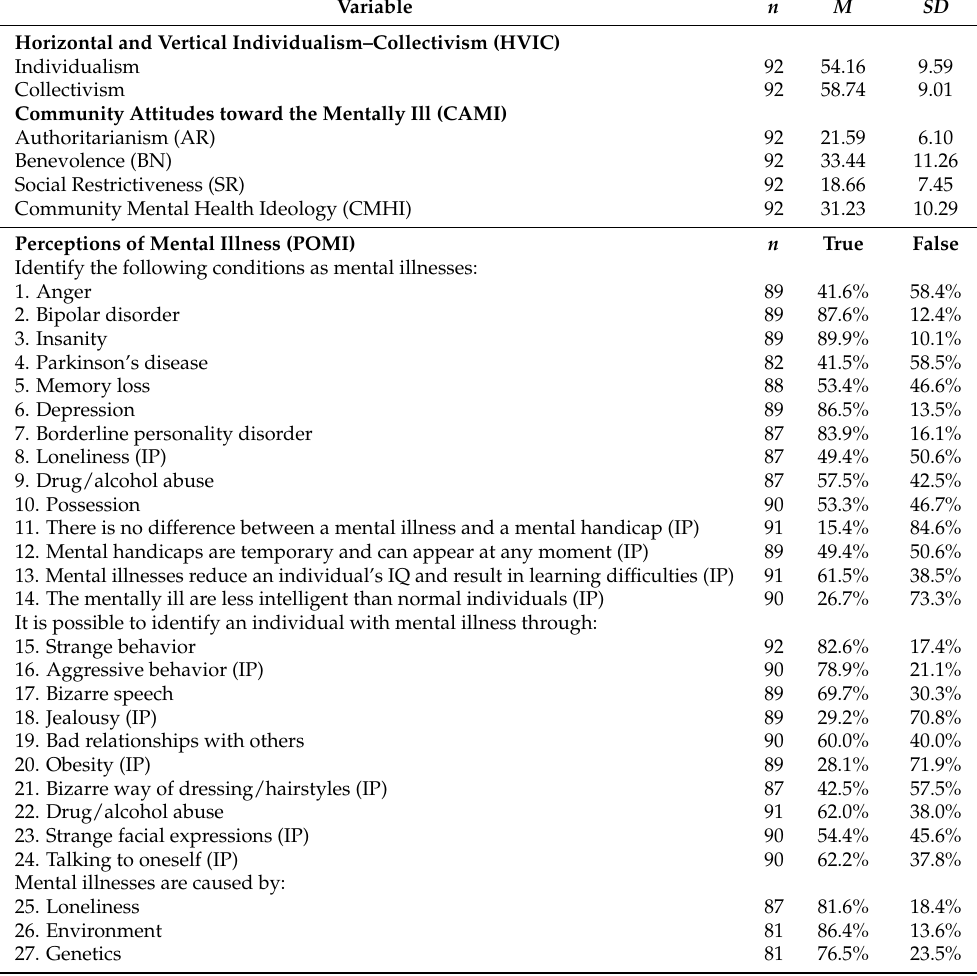
Table 2. Descriptive Statistics of Horizontal and Vertical Individualism–Collectivism (HVIC), Com-